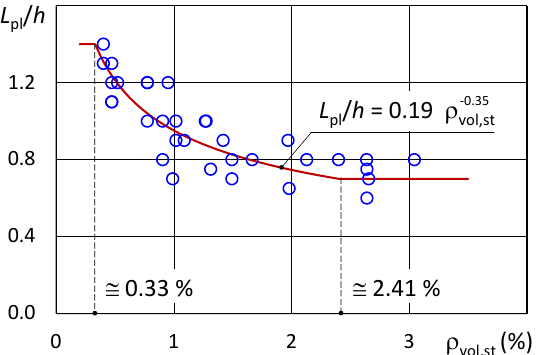
Figure 9. Normalized length of the plastic hinge versus volumetric ratio of transverse reinforcement.